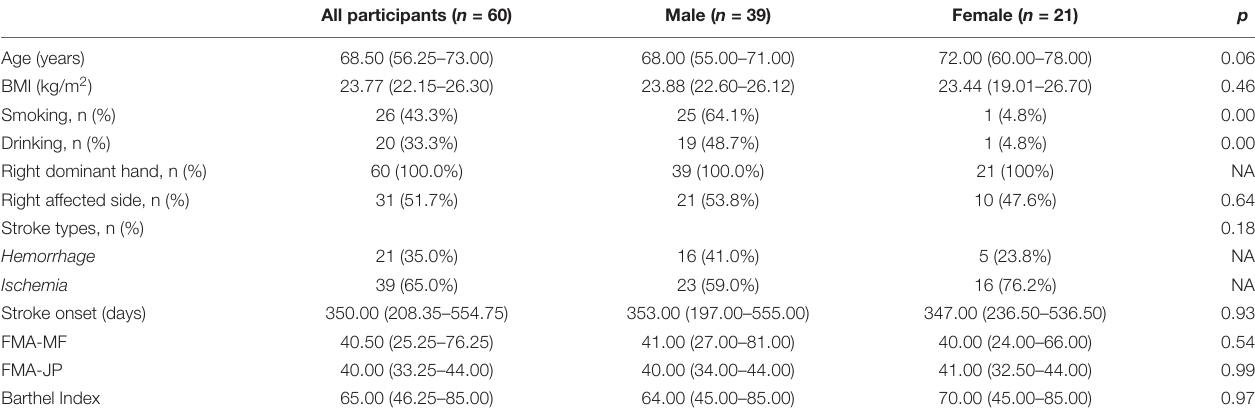
TABLE 1 | Demographics and characteristics of the participants.